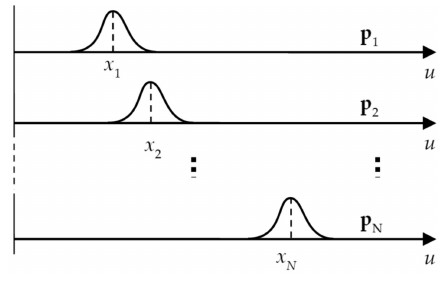
Figure 2. The primary function